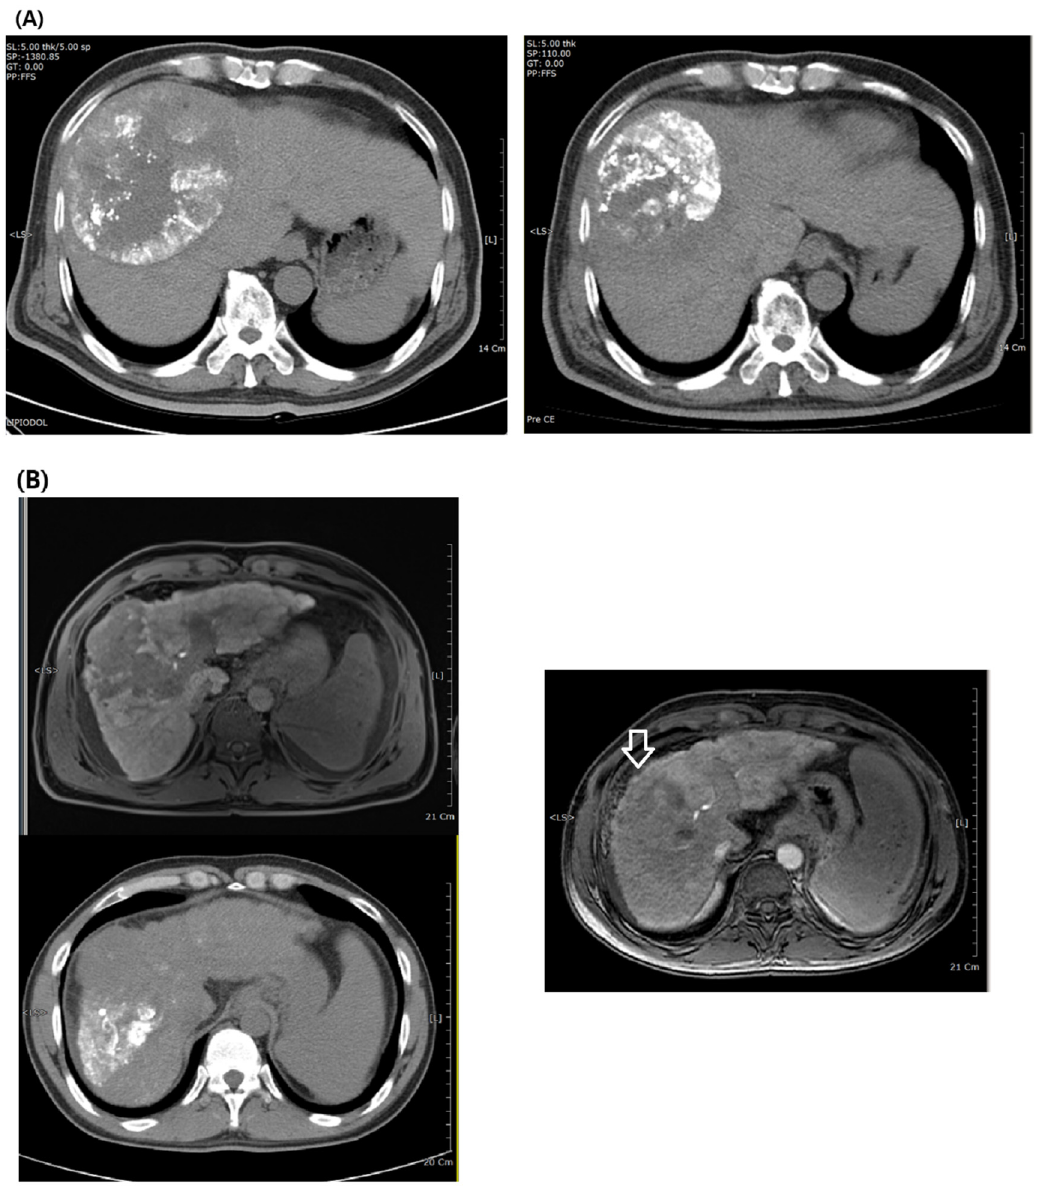
Figure 3. ( A ) Left panel: A 59-year old man diagnosed with hepatitis B virus (HBV)-related hepatocellular carcinoma on segment 8; the diameter of the largest lesion was 13.4 cm. Lipiodol tagging revealed that two rounds of transarterial chemoembolization (TACE) were insufficient, especially at the tumor’s core; right panel: four months after external radiotherapy (40 Gy/16F) and a third round of TACE. The tumor size was significantly decreased, and the efficiency of TACE was enhanced as evidenced by a higher level of lipiodol tagging inside the tumor. ( B ) Left upper panel: A 42-year old man diagnosed with HBV-related hepatocellular carcinoma within a cirrhotic liver. The tumor extended around segment 4 and was accompanied by a left main portal vein thrombus. Left lower panel: The initial TACE only produced physiologic distribution of lipiodol and poor tumor tagging; right panel: one month after EBRT (54 Gy/27 F), the tumor and accompanying right portal vein thrombus significantly decreased (white arrowhead: normalized outline of the liver which the tumor previously extruded).